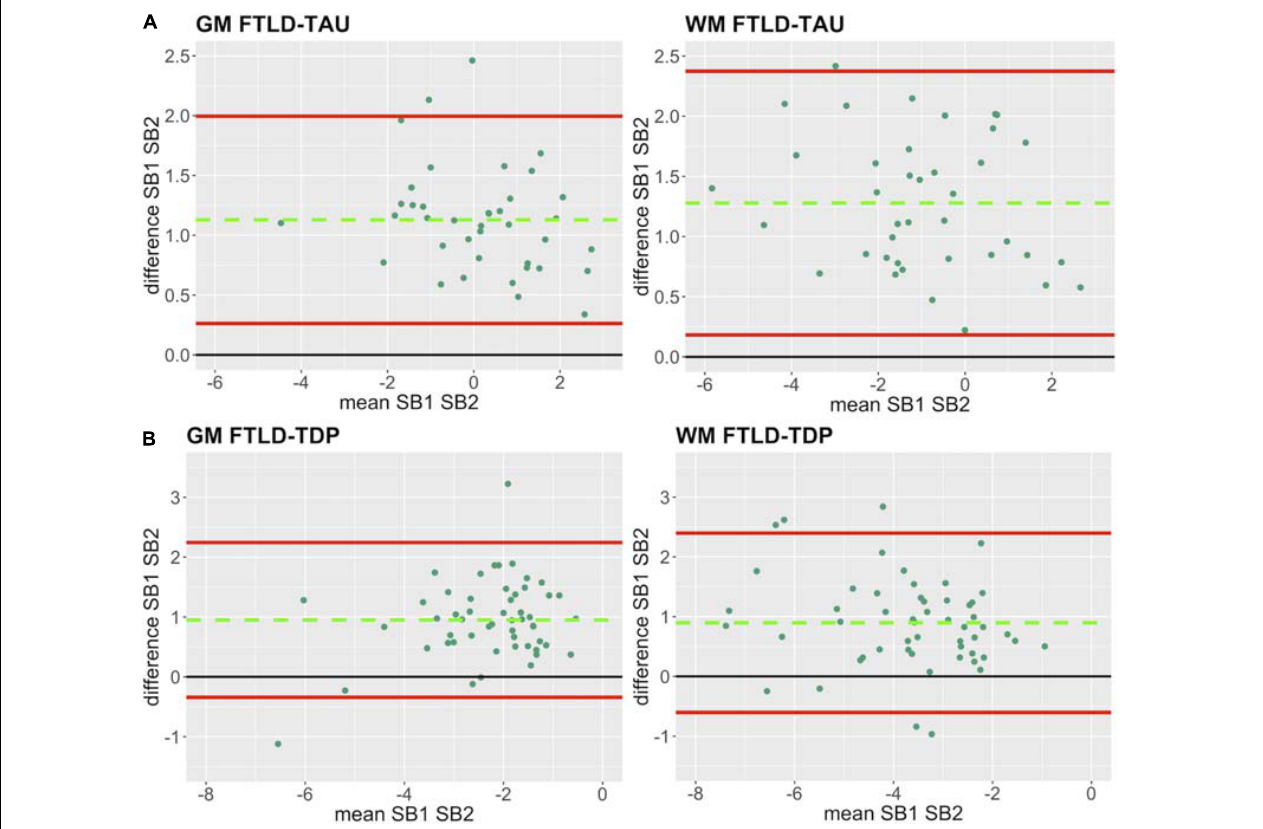
FIGURE 3 | Bland-Altman plots of test-retest agreement between duplicate measurements of pathology from two distinct staining batches. Bland-Altman plots show test-retest agreement between SB1 and SB2 measurements of digital pathology (i.e., ln %AO). The green dashed line indicates the mean difference between SB1 and SB2 measurements, while the red solid lines mark the 95% limits of agreement between the two measurements. We find that mean difference between SB1 and SB2 significantly differs from zero ( p < 0.001) in FTLD-Tau (A) and FTLD-TDP (B) in both GM and WM. FTLD-Tau, frontotemporal lobar degeneration with inclusions of the tau protein; FTLD-TDP, frontotemporal lobar degeneration with inclusions of the transactive response DNA-binding protein 43 kDa; GM, gray matter; SB1, staining batch 1 (original); SB2, staining batch 2 (new); WM, white